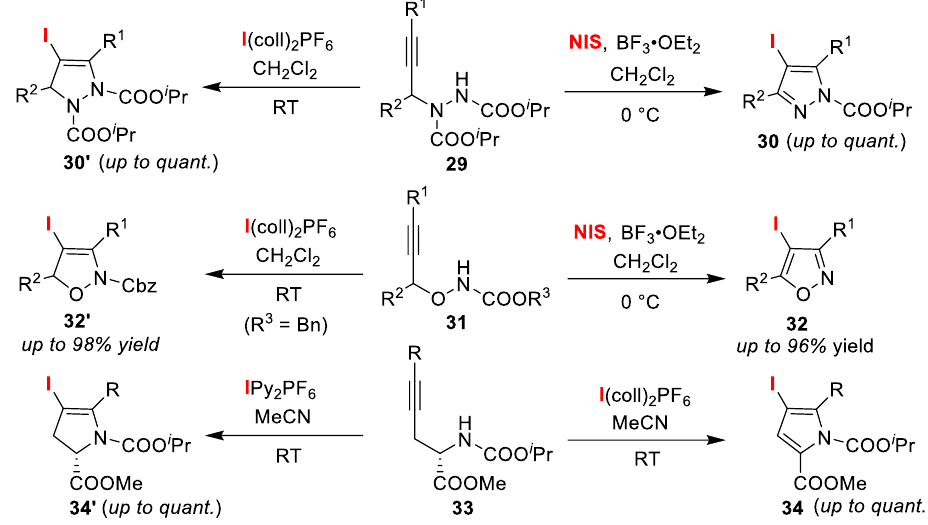
Figure 16. Selective syntheses of five-membered heterocycles via the iodo-cyclization of propargylic hydrazides 29 , N -alkoxycarbonyl propargylic hydroxylamines 31 ,and α -propargylic glycines 33 .